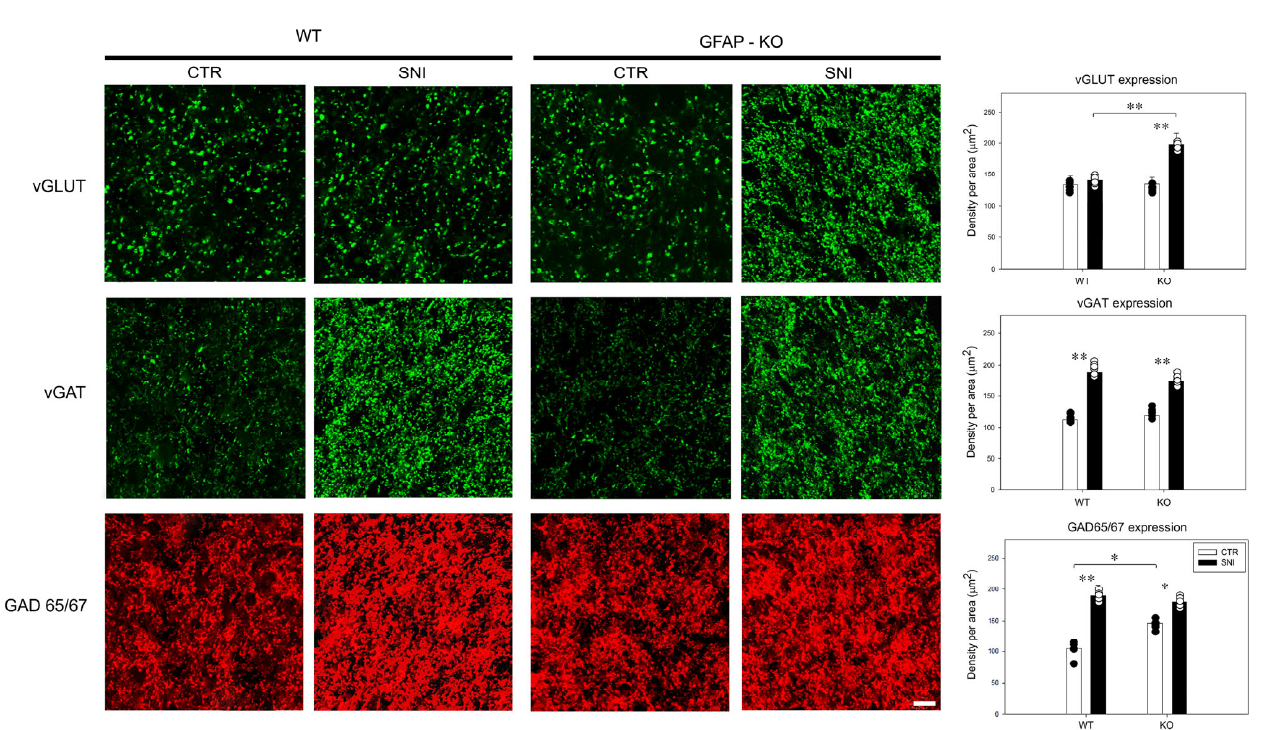
Figure 5. Confocal images of dorsal horns of the lumbar spinal cord in WT (magnification 100×; scale bar, 10 μ m) and GFAP ‐ KO mice (magnification 20×; scale bar, 50 μ m) in CTR and SNI mice, immunostained for vGLUT, vGAT and GAD. Data are expressed as the mean ± SEM (** p ≤ 0.001; * p ≤ 0.01).